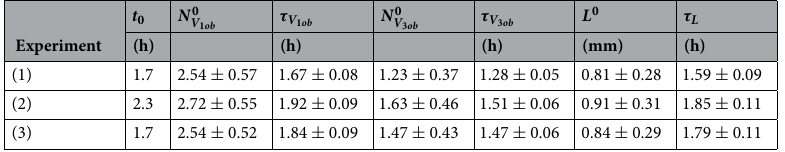
Table 2. Summary of the growth rate exponents for N V 1 ob , N V 3 ob and the total length L extracted from data 2 shown in Fig. 10. The χ values were all found to fall into the range 1–5.